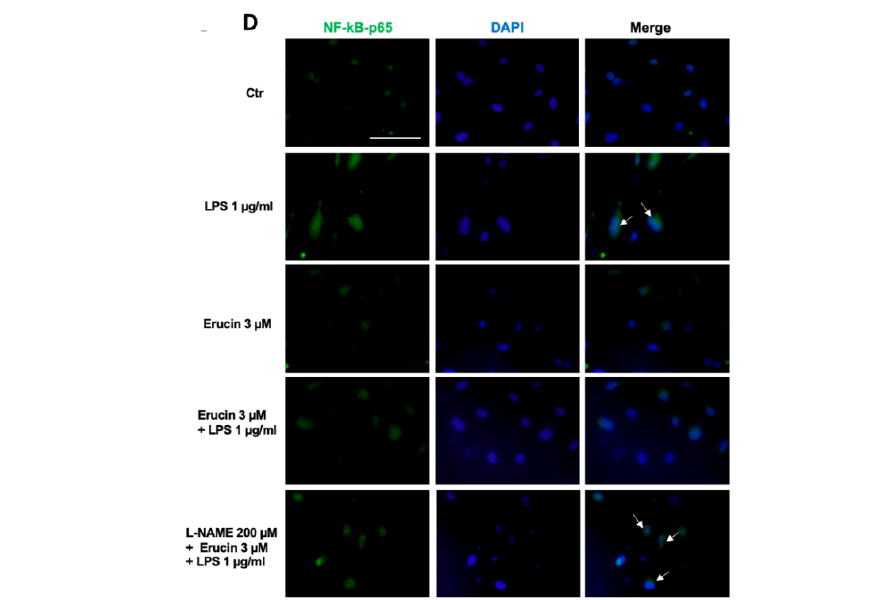
Figure 7. Molecular mechanism elicited by erucin in HUVECs. ( A ) eNOS activation on Ser1177 after 5 and 10 min of erucin treatment (3 µ M). VEGF (25 ng/mL) was used as positive control of eNOS fast activation. The ratio between peNOS Ser1177 and eNOS is reported. Quantification of the optical density of each protein of interest with respect to total eNOS and its β -actin at 5 min ( B ) and 10 min ( C ). ( D ) NF- κ B p65 subunit localization (in green, magnification 63 × ). HUVECs were starved for 4 h, and then pre-treated with erucin (3 µ M) for 1 h followed by LPS (1 µ g/mL, 2 h). Where indicated, HUVECs were pre-incubated with L-NAME (200 µ M, 30 min). White arrows evidence nuclear NF- κ B positivity. *** p < 0.001 vs. vehicle.